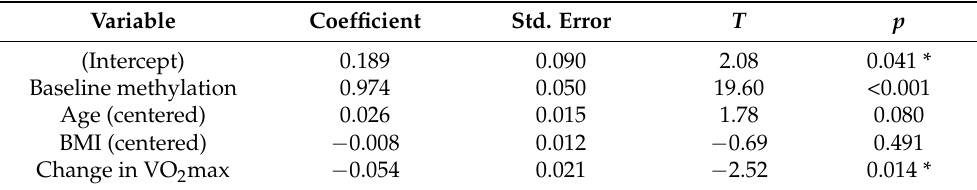
Table 5. BRCA1 (tumor suppressor) methylation at post-intervention regressed compared to baseline methylation, age, BMI, and VO 2 max